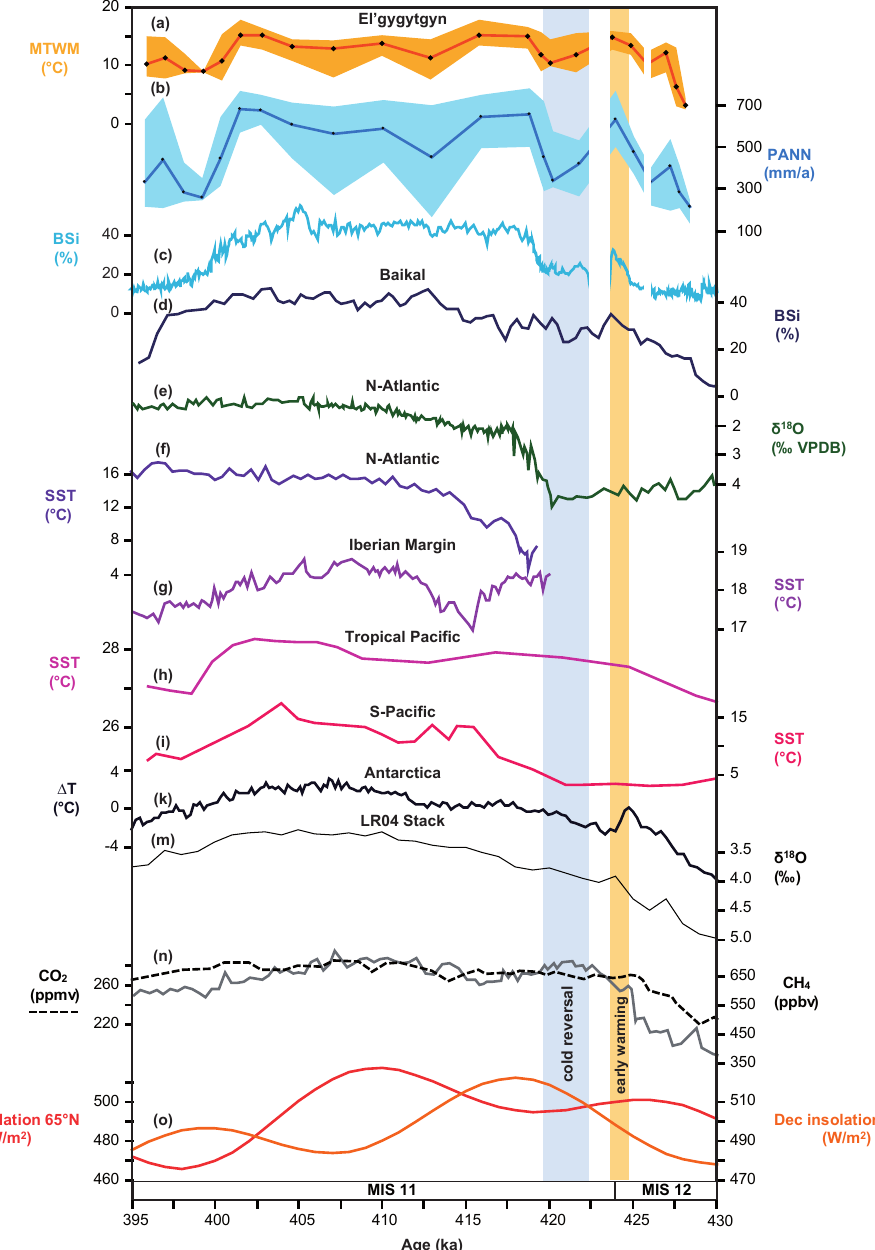
Fig. 4. Comparison of Lake El’gygytgyn climate indicators with other globally distributed climate records between 430–395ka. (a) mean temperature of the warmest month with orange shaded error range (MTWM) from Lake El’gygytgyn (Melles et al., 2012); (b) annual precipitation with blue shaded error range (PANN) from Lake El’gygytgyn (Melles et al., 2012); (c) FTIRS inferred biogenic silica (BSi) concentrations from Lake El’gygytgyn; (d) biogenic silica (BSi) concentrations from Lake Baikal (Prokopenko et al., 2006); (e) oxygen isotopes of planktic foraminifera (right-coiling N. pachyderma ) from the N. Atlantic (ODP site 980; Oppo et al., 1998); (f) sea surface temperatures (SST) from the N. Atlantic (Kandiano and Bauch, 2007); (g) SSTs from the Iberian Margin/N. Atlantic (Martrat et al., 2007); (h) SSTs from the tropical Pacific (Li et al., 2011); (i) SSTs from the S. Pacific (Schaefer et al., 2005); (k) temperature anomaly relative to the mean of the last 1000yr ( 1 T) from the EPICA Dome C ice core record (Jouzel et al., 2007); (m) LR04 benthic oxygen isotope stack (Lisiecki and Raymo, 2005); (n) CO 2 (Siegenthaler et al., 2005) and CH 4 (Loulergue et al., 2008) concentrations from the EPICA Dome C ice core record; (o) summer insolation at 65 ◦ N (June) and 65 ◦ S (December; Laskar et al., 2004). Orange shading highlights the early warming and blue shading the cold reversal at Lake El’gygytgyn. The age model error for an individual date in the respective interval from Lake El’gygytgyn is in the order of 4kyrs (Nowaczyk et al.,